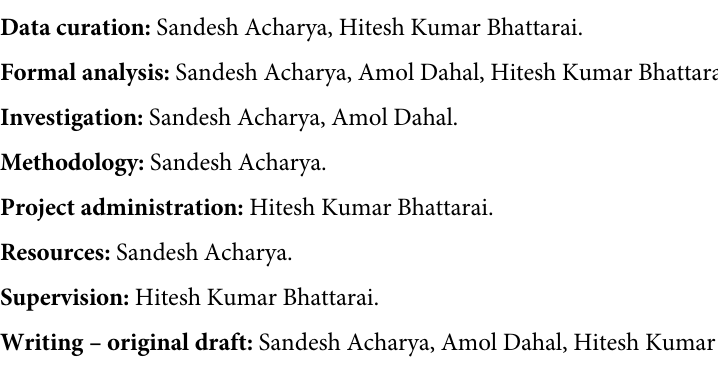
S3 Fig. Multiple alignment of archaeal PCNA under 60% conservation. Only the highlighted residues are conserved at 60% cutoff. S4 Fig. Multiple alignment of sliding clamp proteins from all three domains of life under 60% conservation. The sequences of sliding clamps from different species representing all domains and most classes were aligned and the highlighted residues depict the conserved resi- dues across all three domains of life. Note that only the second and third domain of bacterial beta clamp are selected for alignment. S5 Fig. Multiple alignment of bacterial beta-clamps (second and third domain). The highlighted residues are conserved at 60% conservation level. S6 Fig. Multiple alignment of archaeal and eukaryal PCNA. The highlighted residues are conserved at 60% conservation level. (SVG) S1 Data.